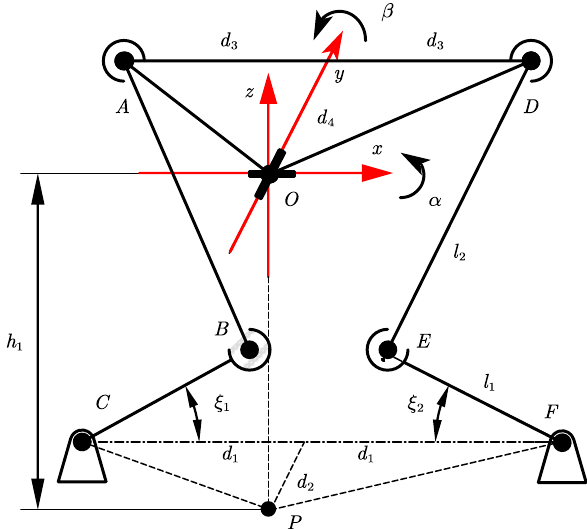
Figure 6. The schematic of pitch and roll control. Plane AOD indicates the stroke plane. Rod BC and EF indicate the servo